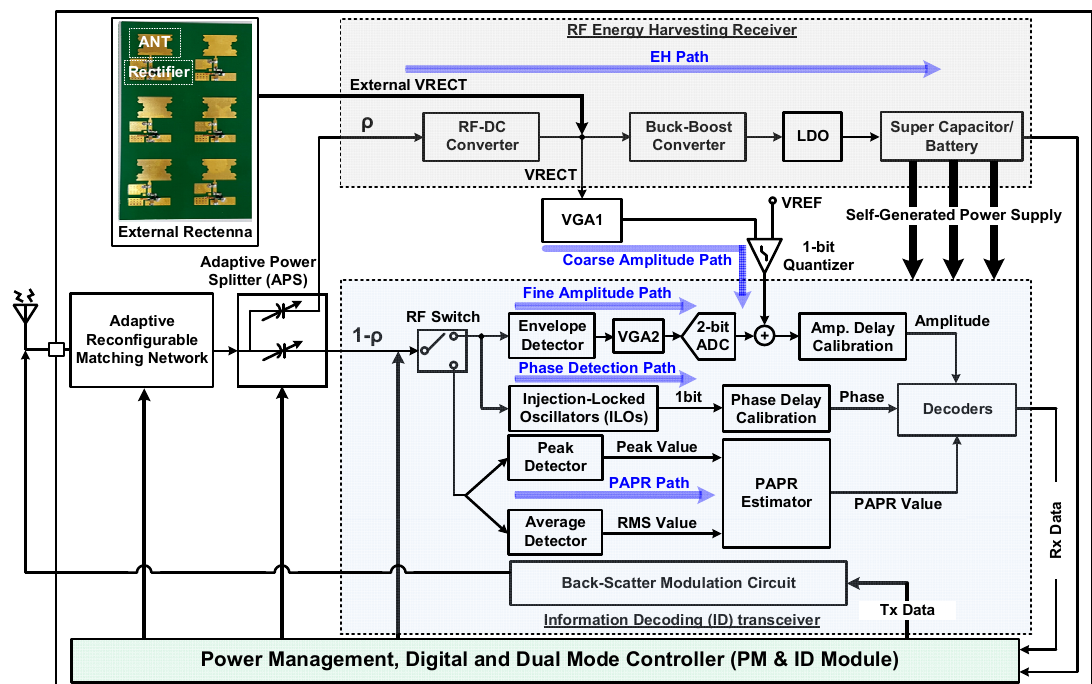
Figure 2. Top block diagram of the dual-mode SWIPT.